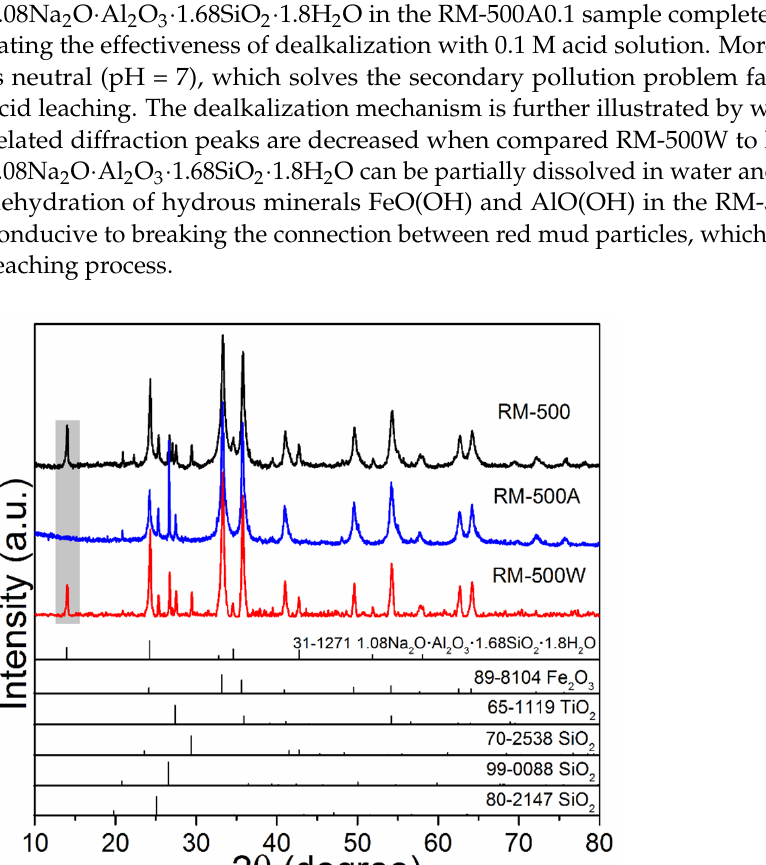
Table 3. The chemical composition, weight loss, and the dealkalization rate of samples (wt.%). Sample Fe Al Si Na Ti Ca Mass Loss/%